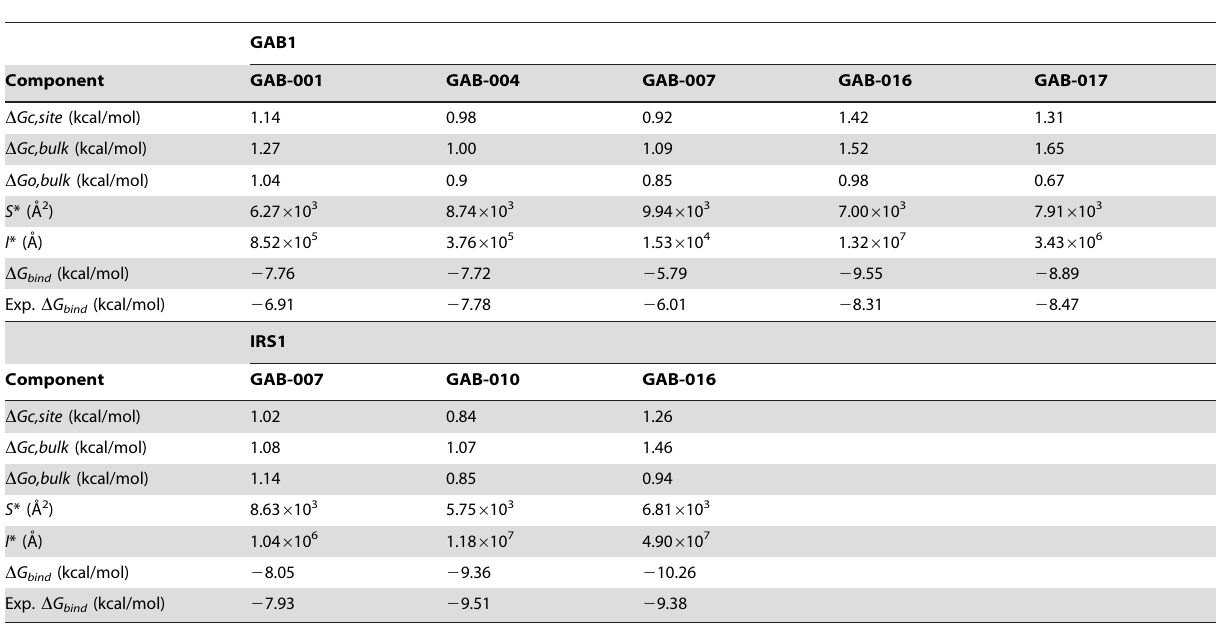
Table 2. Computation of the absolute binding free energy using PMF-based